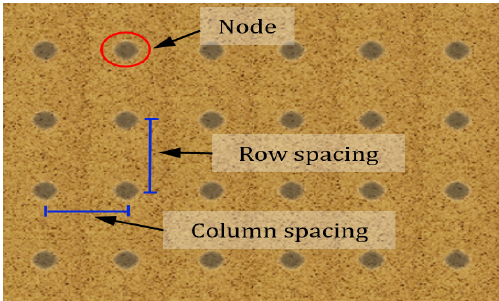
Figure 2. Example of specific row/column planting distances. The row and column spacing are selected based on the type of